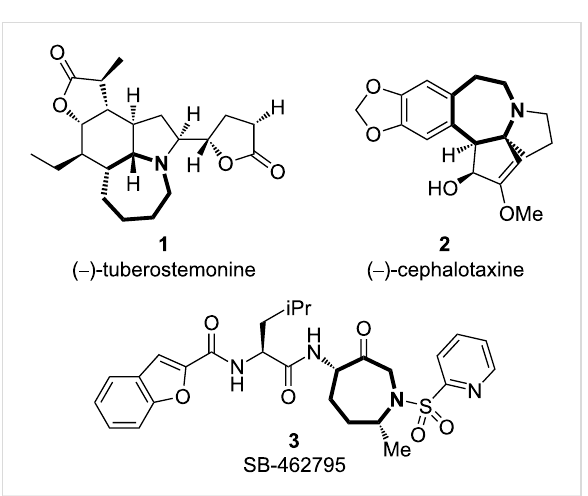
Figure 1: Azepine frameworks found in natural products and pharma- ceuticals.